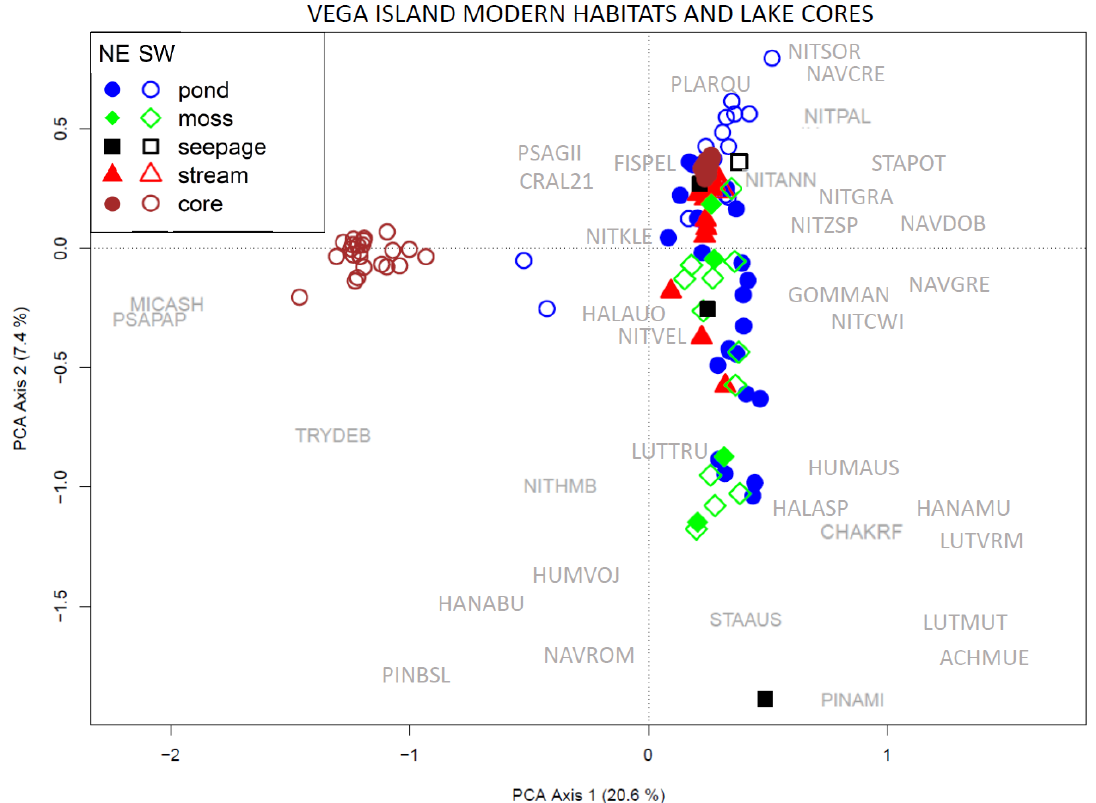
Figure 7. The principal component analysis (PCA) of the entire Vega Island dataset, including all taxa with a relative abundance > 4% in at least one sample. Pond habitats are indicated by blue circles, core samples by brown circles, moss habitats by green diamonds, seepages by black squares, and streams by red triangles. Symbols for Devil’s Bay are filled, and Cape Lamb sites are represented by outlines only. Diatom species with a relative abundance > 10% in at least one sample are superimposed, and the key for species abbreviations is given in Table S2.